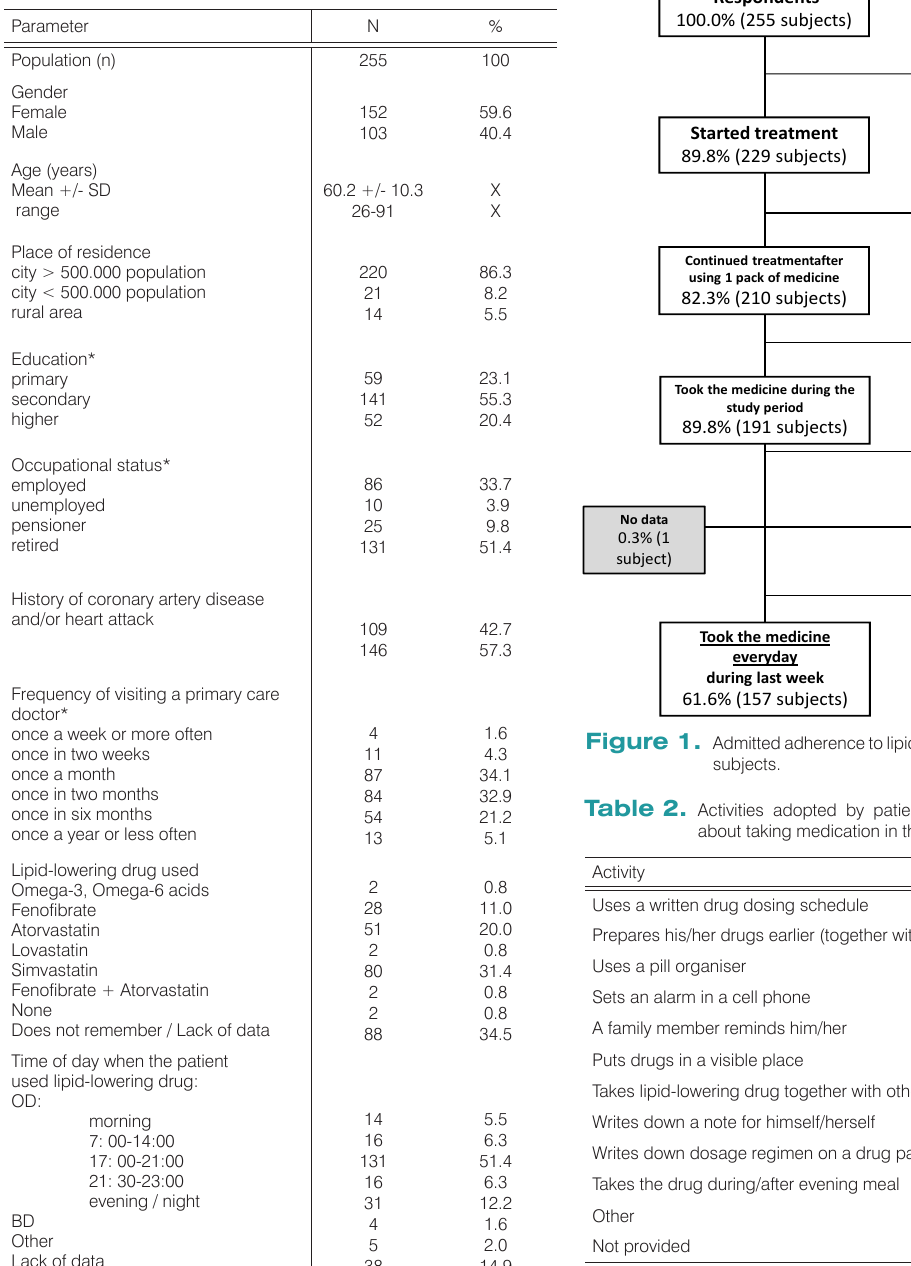
Table 1. Respondents’ characteristics.